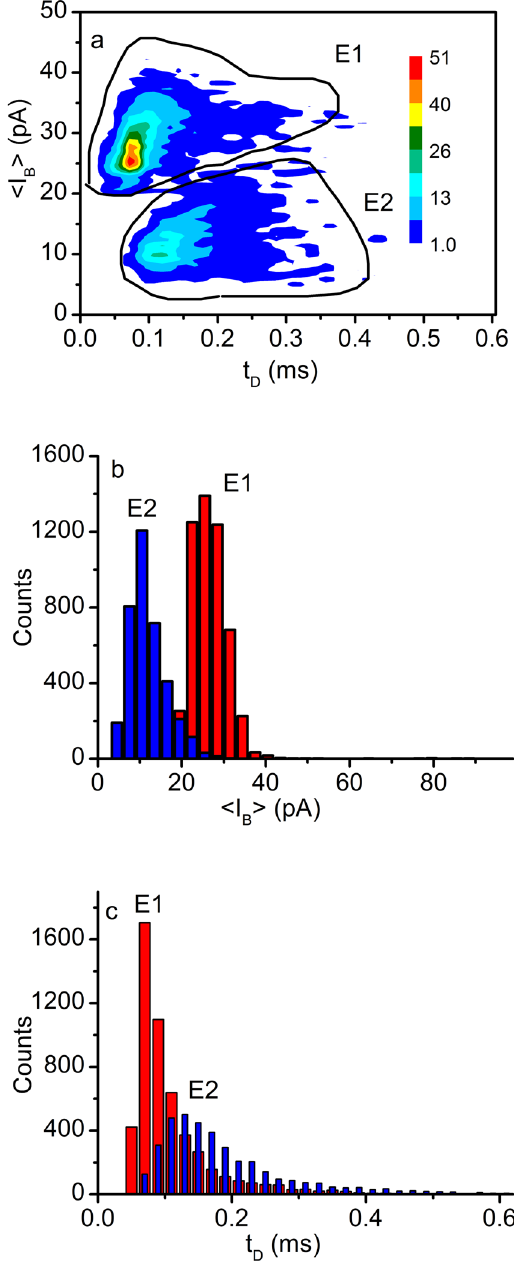
Figure 2. Analysis of the blockage events recorded after Ang II addition to the cis reservoir at − 80 mV transmembrane potential. ( a ) The density plot shows two well-defined clusters (named E1 and E2), which allowed separate analysis of each individual cluster. The color indicates the density in accordance to the inserted scale. ( b ) The < I B > histograms (bin width 3 pA) present peaks at ~26 pA (E1 events) and ~10 pA (E2 events). ( c ) The distribution of events for each of the two clusters in terms of t D is represented by histograms (bin width 0.02 ms) with peaks at ~70 µ s (E1 events) and ~120 µ s (E2 events). A gap between the bins for the E2 events has been introduced for better observation of the overlapped distributions. The analyzed events were collected from a single translocation